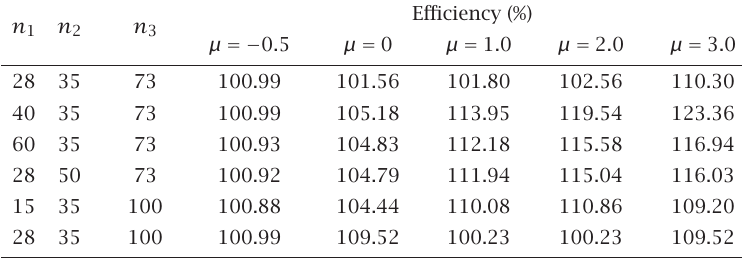
∗ ( X 3 ) relative to d G 2 ( X 3 ) 2 , w